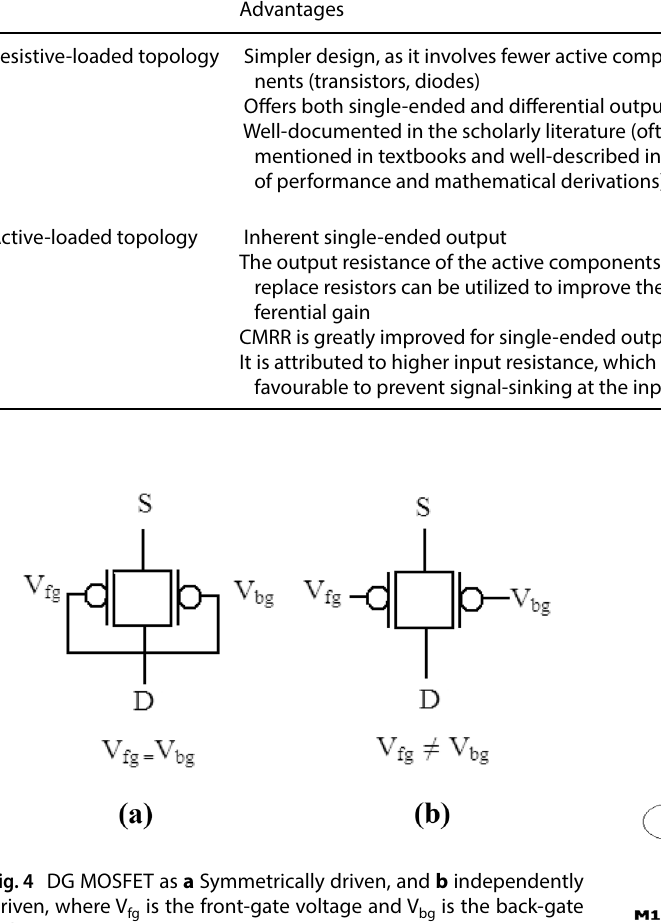
is the back-gate bg